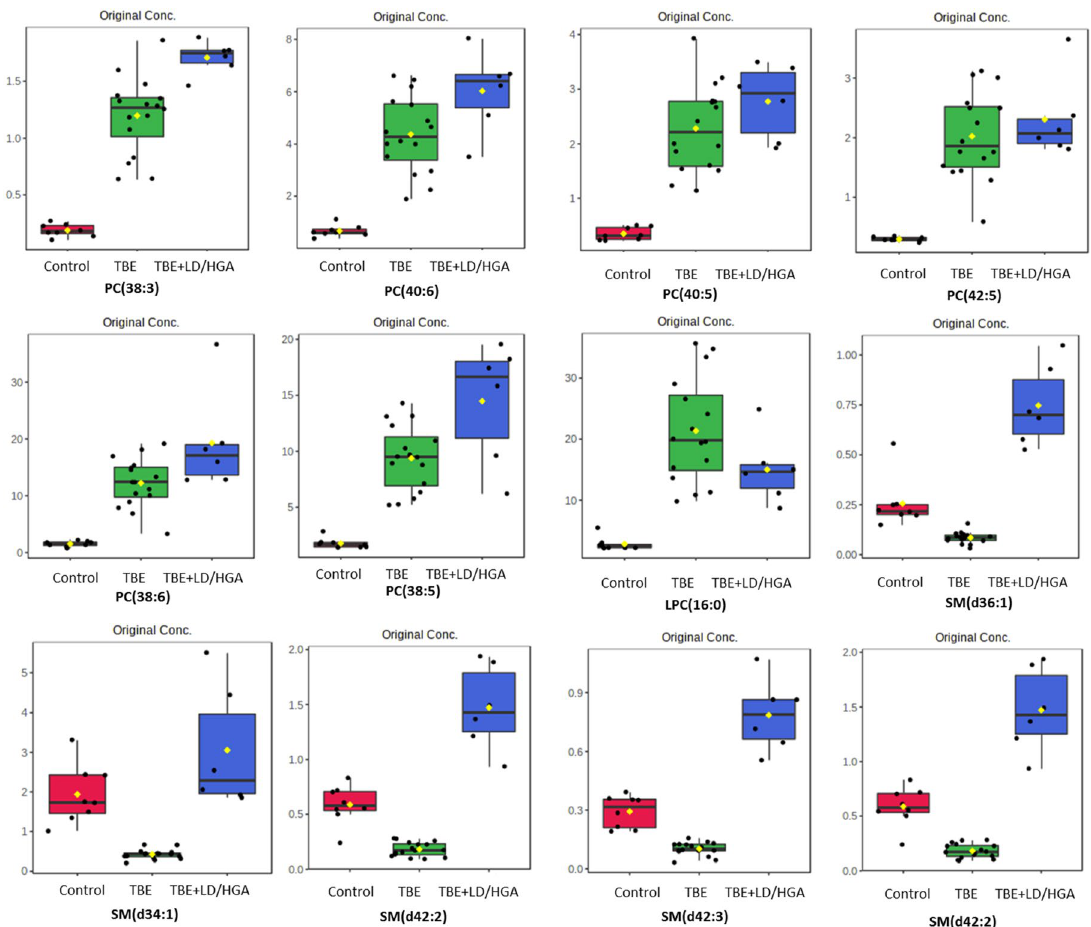
Figure 3. Relative abundances of differential (according to One-way ANOVA) PL species in the plasma samples collected from patients and healthy subjects. (red box: control group; blue box: TBE patients co-infected with LD/HGA; green box: TBE